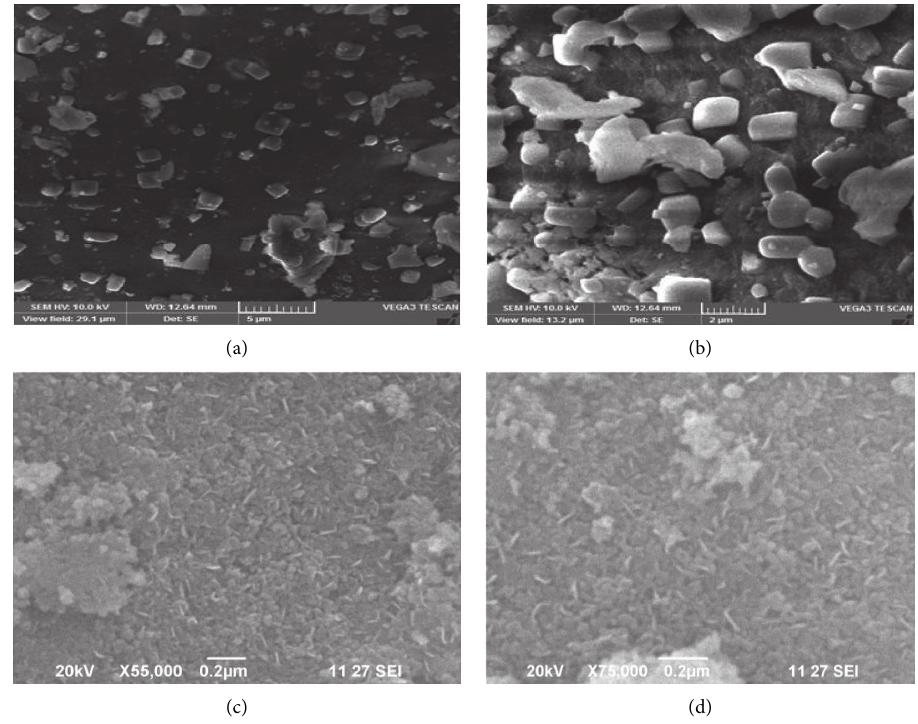
Figure 6: SEM images of MgO nanoparticles at 500 ° C (a), 600 ° C (b), and 700 ° C (c,